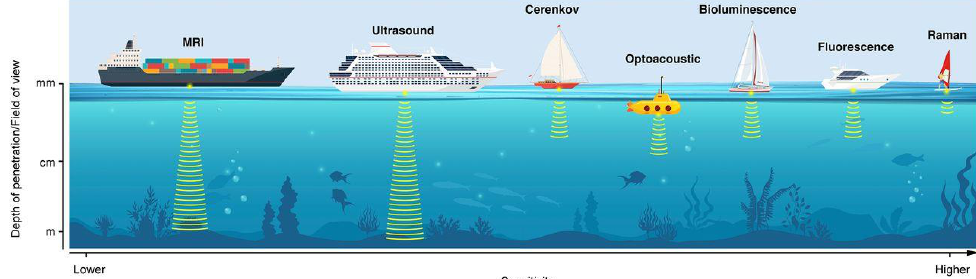
Figure 3. Schematic representation of various optical imaging modalities discussed in this review. Different modalities are represented as different boats, each with its individual pros and cons and its specific utility. The x -axis represents sensitivity (lower to high, left to right). The y -axis represents the depth of penetration/field of view, as indicated below each boat. Reprinted with permission from Ref. [68]. Copyright 2020, Society of Nuclear Medicine and Molecular Imaging.